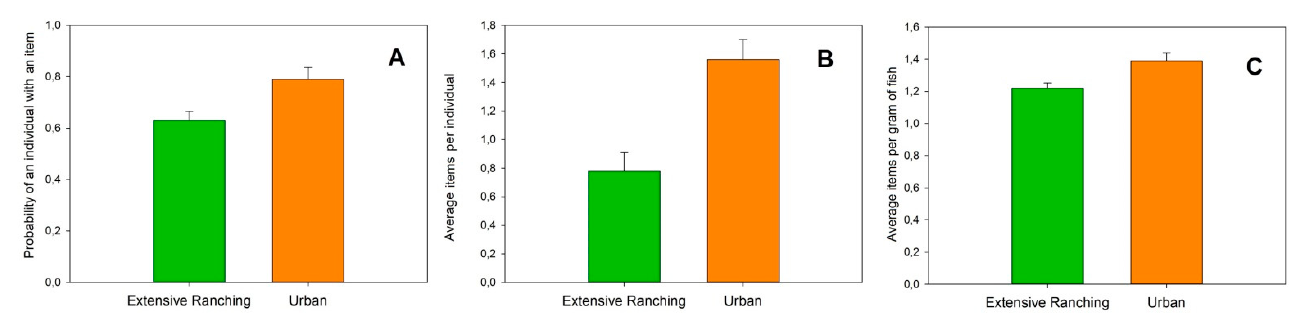
Figure 5. ( A ) Mean and standard deviation of the probability of collecting a fish containing at least one plastic itemin Extensive Ranching and Urban streams. ( B ) Mean and standard deviation of the number of plastic itemsper individual for Extensive Ranching and Urban streams. ( C ) Average number of plastic items per gram of fish and their deviation for Extensive Ranching and Urban streams.